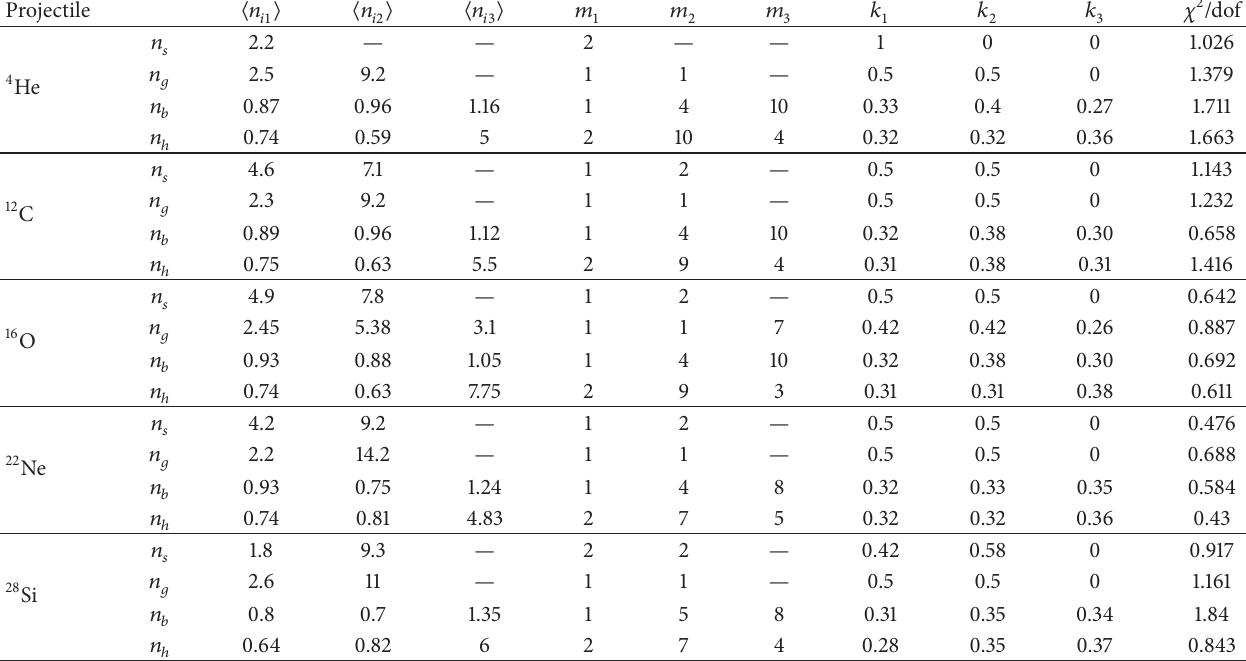
Table 2: Parameter values for multiplicity distributions for shower, grey, black, and heavy particles. The values of ⟨𝑛 𝑖1 ⟩ , ⟨𝑛 𝑖2 ⟩ , and ⟨𝑛 𝑖3 ⟩ and 𝑚 𝑚 𝑘 𝑘 𝑘 𝑚 4 He-, 12 C-, 16 O-, and 28 Si-Em at 4.5 AGeV/c and 22 Ne-Em at 4.1AGeV/c. 1 , 2 , and 3 , and 1 , 2 , and 3 for